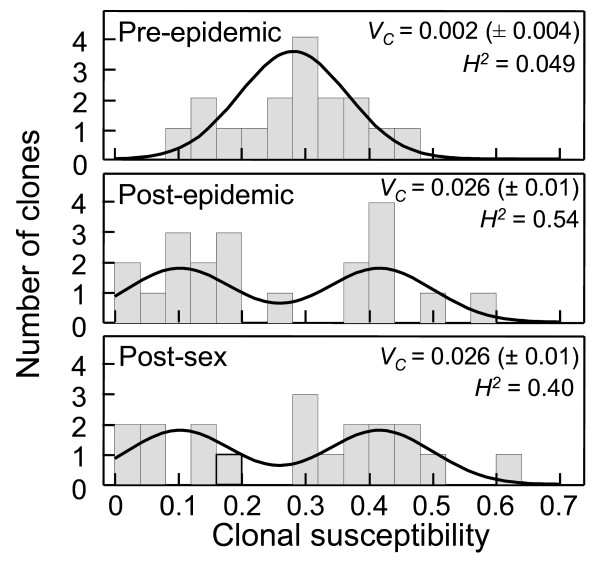
Distributions of clonal susceptibility in the D. dentifera population. Panels show the distribution of clonal susceptibility before (top panel) and after (middle panel) the epidemic and after sexual reproduction (bottom panel). Histograms showing the experiment data are shown with probability density functions for the best fit model (Table 1) overlain. Probability density functions are scaled to a similar area under each curve as the area of the data in the histograms. Clonal variance (VC; ± 1 standard error) and broad-sense heritability (H2) estimates are given for each time period.